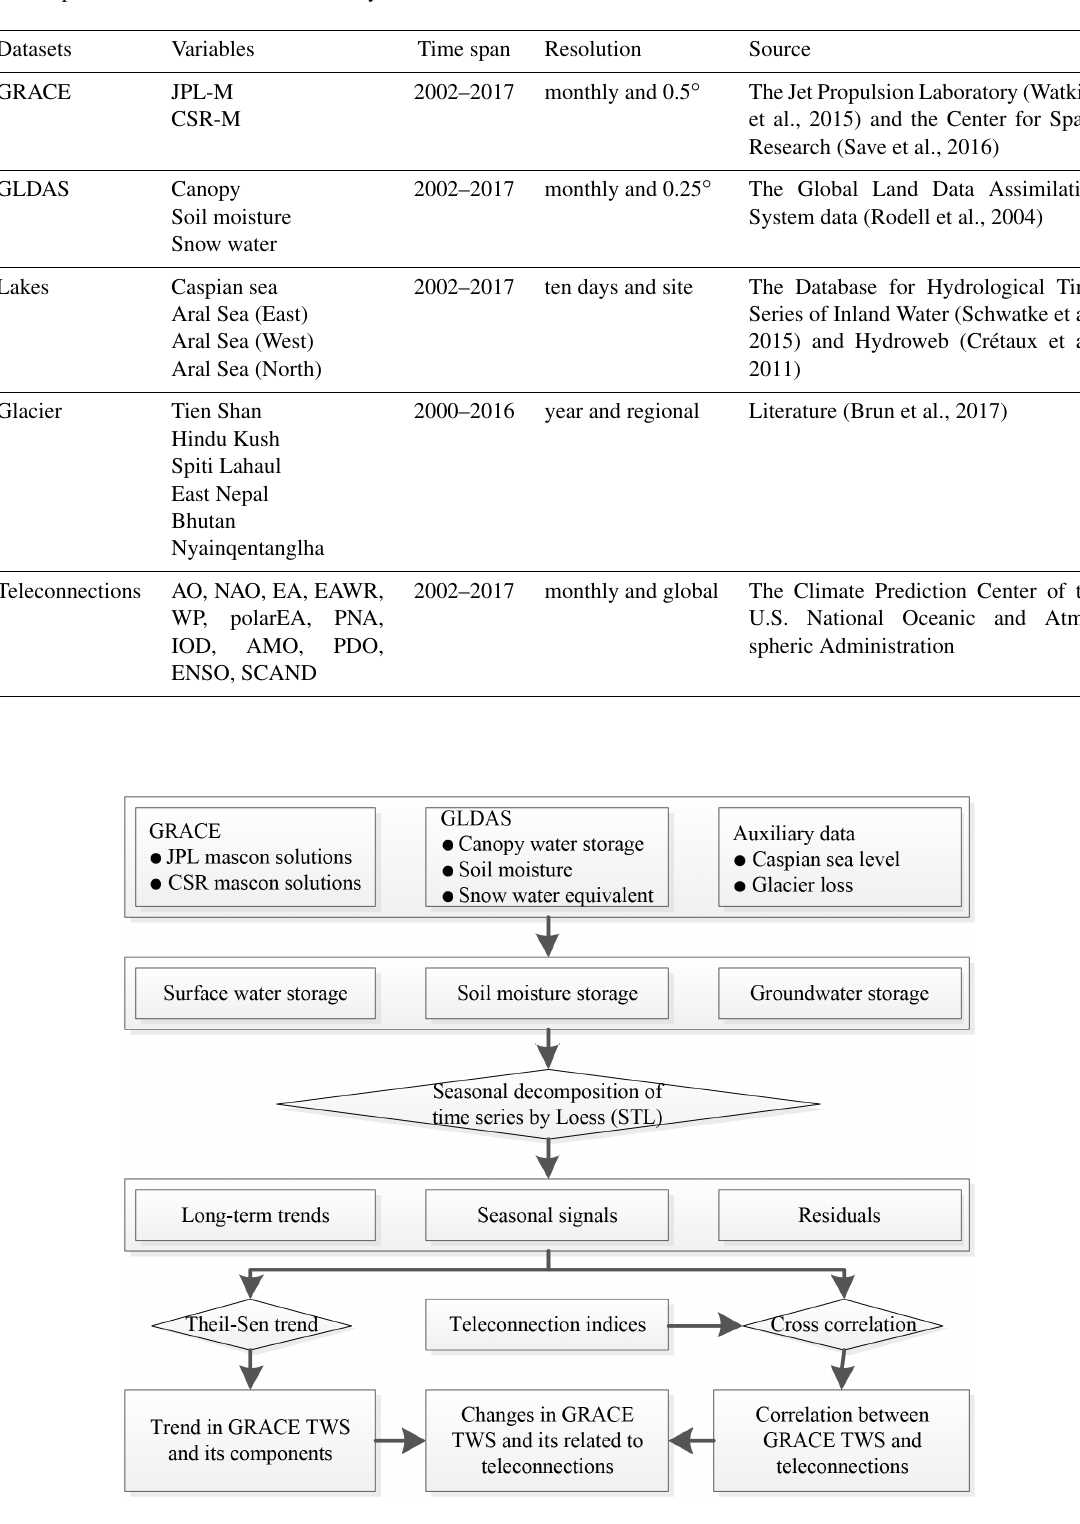
Figure 2. Methodology flow diagram of data processing in this